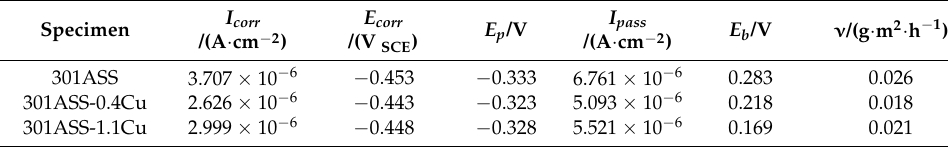
Figure 7. Polarisation curves of Cu-bearing 301 ASS in 3.5 wt.% NaCl solution. Table 2. Electrochemical parameters of Cu-bearing 301 ASS.